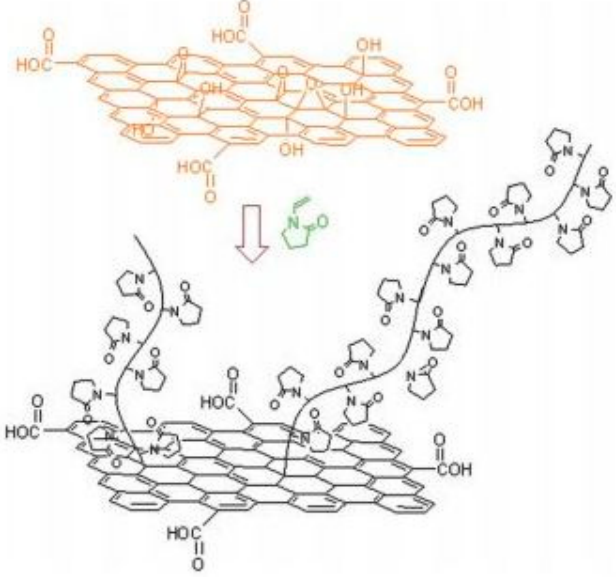
Figure 4. GO surface-initialized polymerization of N-vinylpyrrolidone [19].